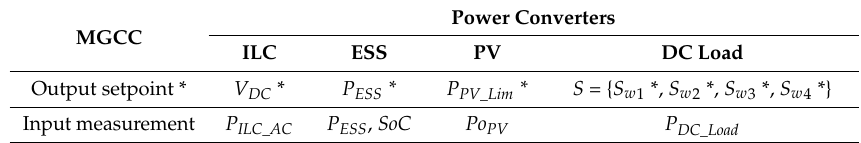
Table 1. Parameters broadcasted between the power converters of the DC microgrid and the MGCC.